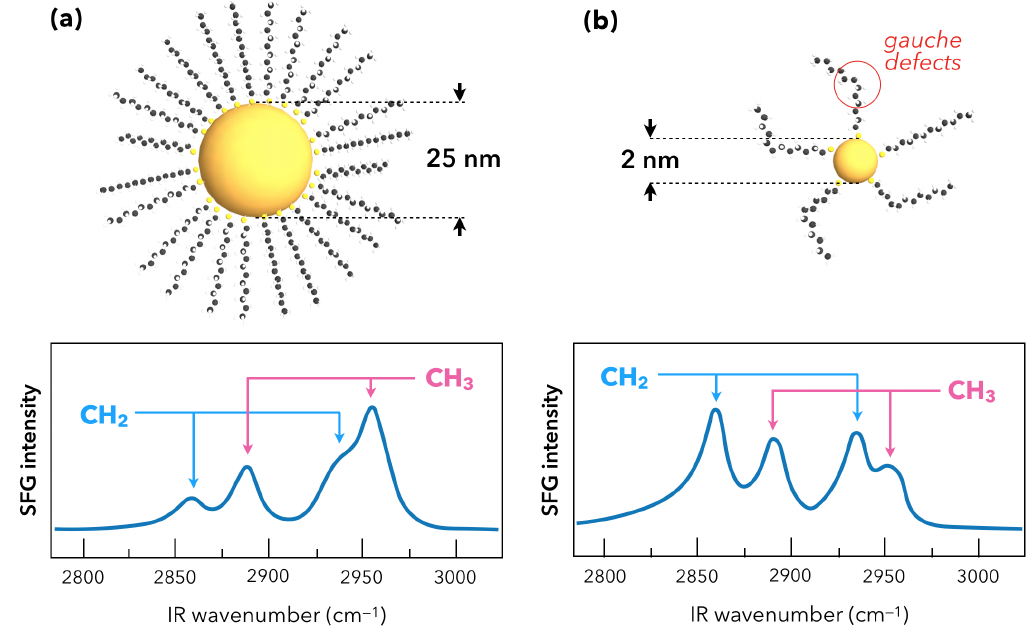
Figure 6. Evolution of the SFG vibrational fingerprint (C-H spectral range) of dodecanethiol molecules (DDT) adsorbed on AuNPs of 2 nm ( a ) and 25 nm ( b ) diameter, respectively. In Figure 6a, the methyl (CH 3 ) vibration modes intensity dominates the SFG contribution while in Figure 6b, the methylene (CH 2 ) groups dominate the SFG contribution. As detailed in the text and in references from which the picture is adapted [56,57], this is related to the density of gauche defects in the DDT alkane chains depending on the accessible surface and the ability to move in its surroundings.